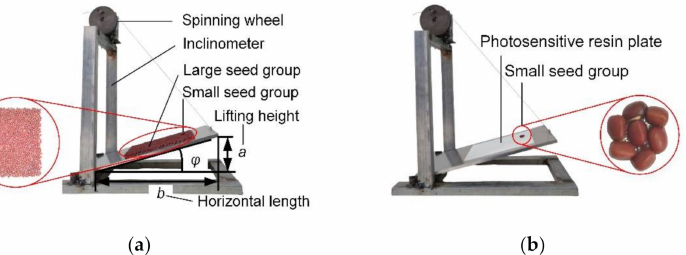
Figure 4. Measurement of coefficient of static friction. ( a ) coefficient of static friction of ABS–ABS; ( b ) coefficient of static friction of ABS–PRP.